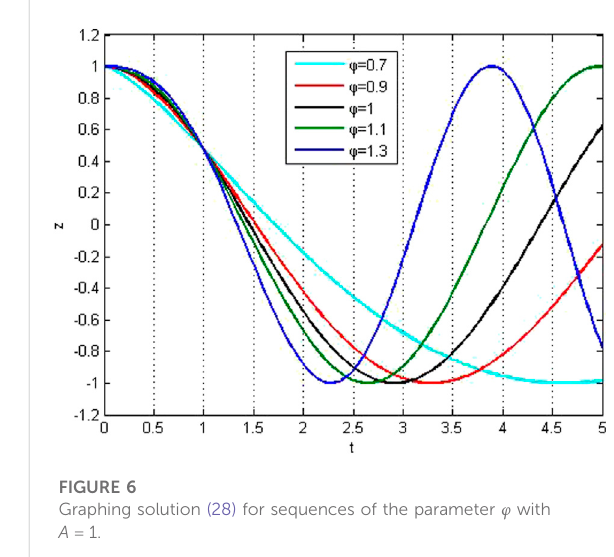
FIGURE 4 Illustration of the second-order approximate solution with A (cid:2) 5.